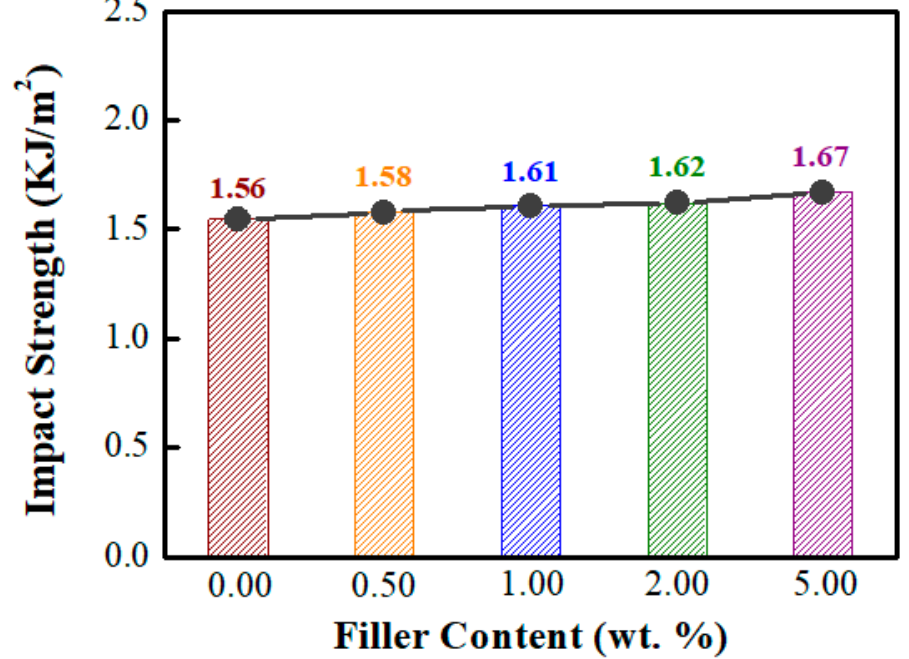
Figure 7. Impact strength of neat K–LCE and its composites filled with different Si–BN contents. Polymers 2018 , 10 , x FOR PEER REVIEW